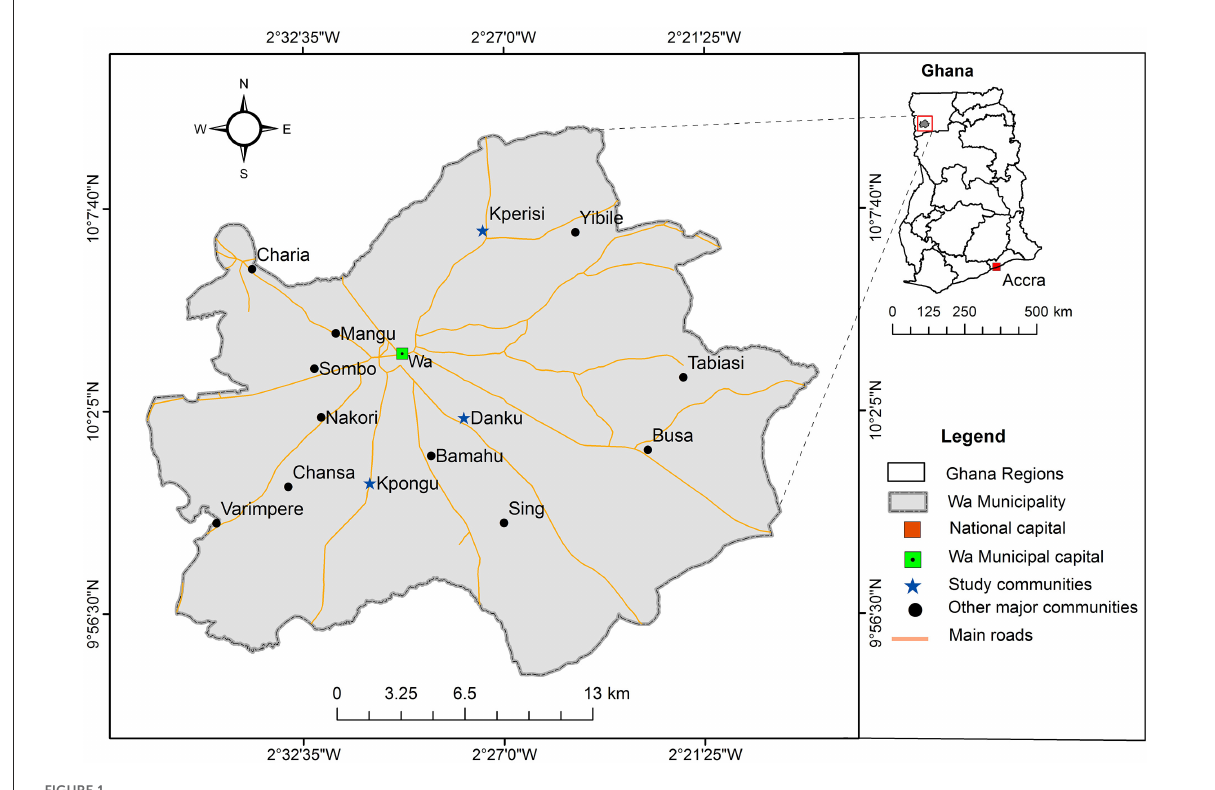
FIGURE1 Map of the Wa Municipality showing the Study sites. Source: Author Construct,